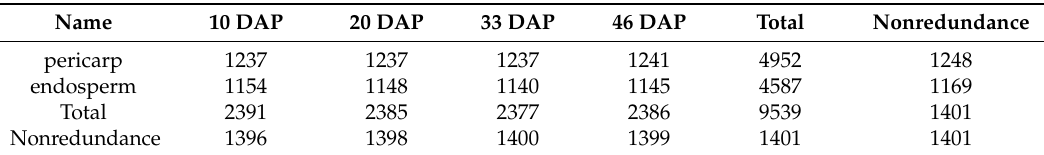
Table 1. The information of proteins identified using isobaric tags for relative and absolute quantitation (iTRAQ).